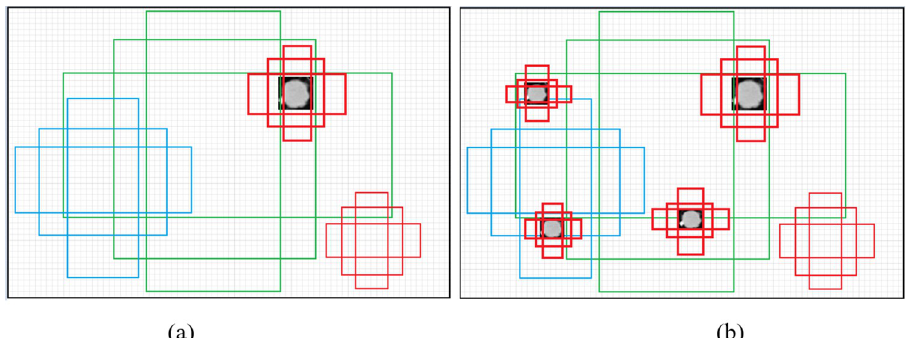
Fig 14. Schematic diagram of anchor frame matching with pulmonary nodules. (a) Anchor frames that matched images of pulmonary nodules in the baseline training set. (b) Anchor frames that matched images of pulmonary nodules in the training set after random oversampling.